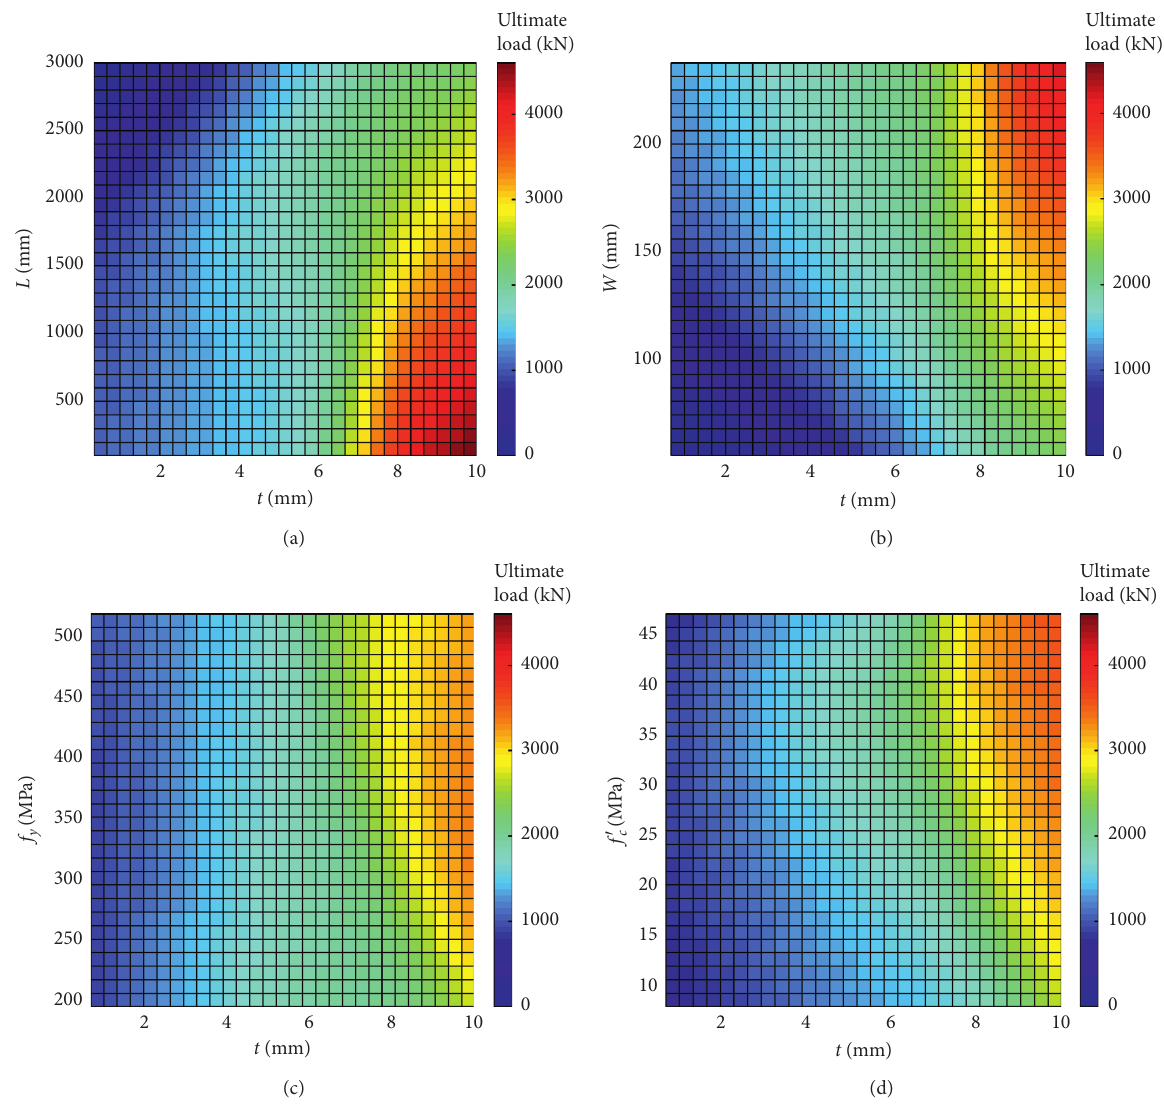
Figure 9: Maps of ultimate load as a function of (a) t - L , (b) t - W , (c) t - f